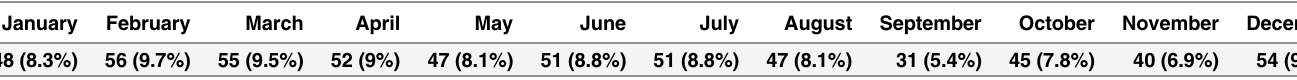
Table 4. Distribution of onsets of MD episodes along the